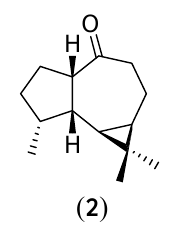
Figure 2: (-)- Allo -aromadendrone ( 2